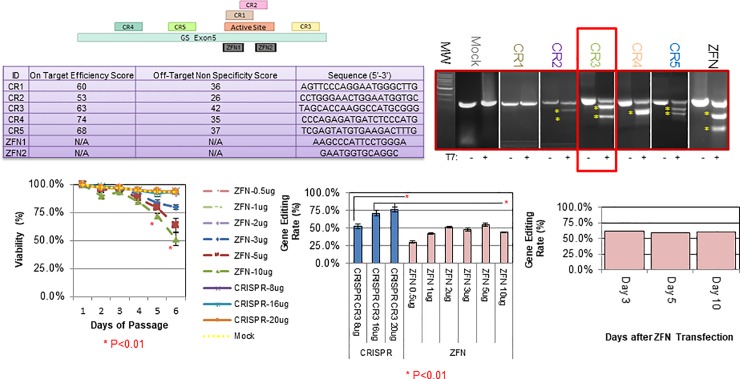
Comparison of ZFN mRNA vs. CRISPR RNP at the glutamine synthetase locus.Five gRNAs were designed to target GS exon 5. The active site is designated in light red, while the gRNA binding sites are labeled CR1-5 (top left panel). ZFN binding sites from Fan et al. are indicated as the grey ZFN1 and ZFN2 boxes. Doench scores demonstrating the predicted on-target (cleavage) efficiency as well as the predicted off-target (cleavage of non-target sites) are predicted in silico within the table (left hand table). Cells were then transfected with CRISPR RNPs 1 through 5, and gDNA was PCR amplified & subjected to a T7 endonuclease assay, with or without addition of nuclease (shown by a + or—; top right hand panel). Yellow asterisks indicate cleavage products, and successful editing. The most efficacious gRNA, CR3, is boxed in red. CHO cells were then transfected with the indicated amounts of Zinc Finger mRNA or Cas9 CR-3 RNP. Cells were assessed daily for viability (bottom middle panel, D5&6 ZFN 3-10ug P<0.01 vs mock). Two days after transfection, equal aliquots of cells from each were lysed and the percentage of mutant alleles were quantified (middle panel, CR3 16ug or CR3 20ug P<0.01 vs all ZFN conditions). Significance using student’s T-test is demonstrated by a red asterisk. To ensure temporal effects did not result in reduced efficacy of the ZFN mRNA vs CRISPR RNP, ZFN transfected cells were continually passaged and then lysed and analyzed five and ten days after the initial transfection (bottom right hand panel).